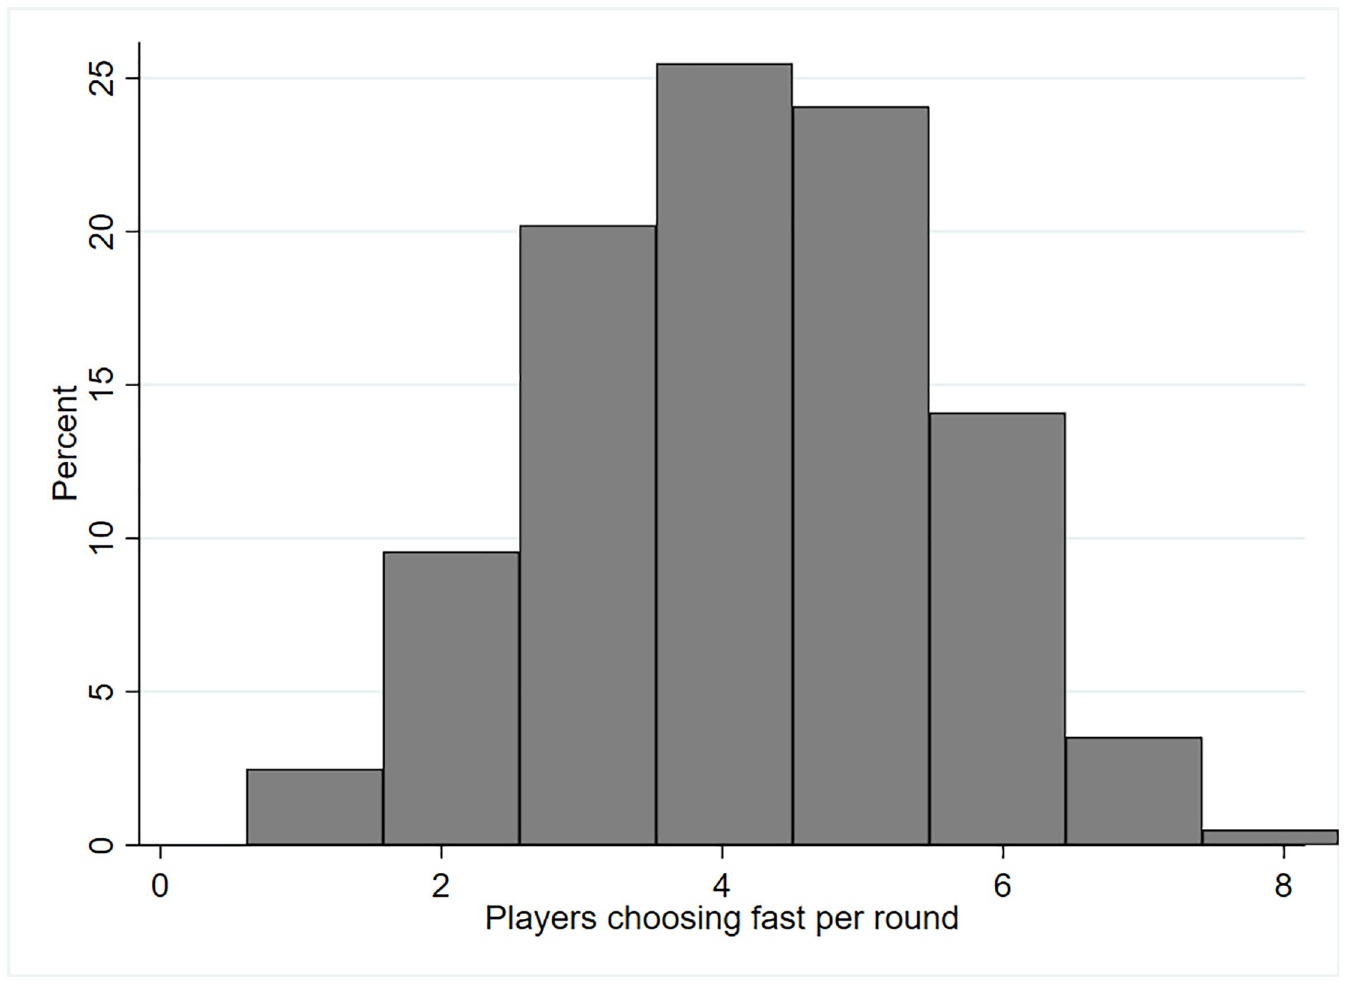
Fig 2. Number of players choosing fast per round in percentage.